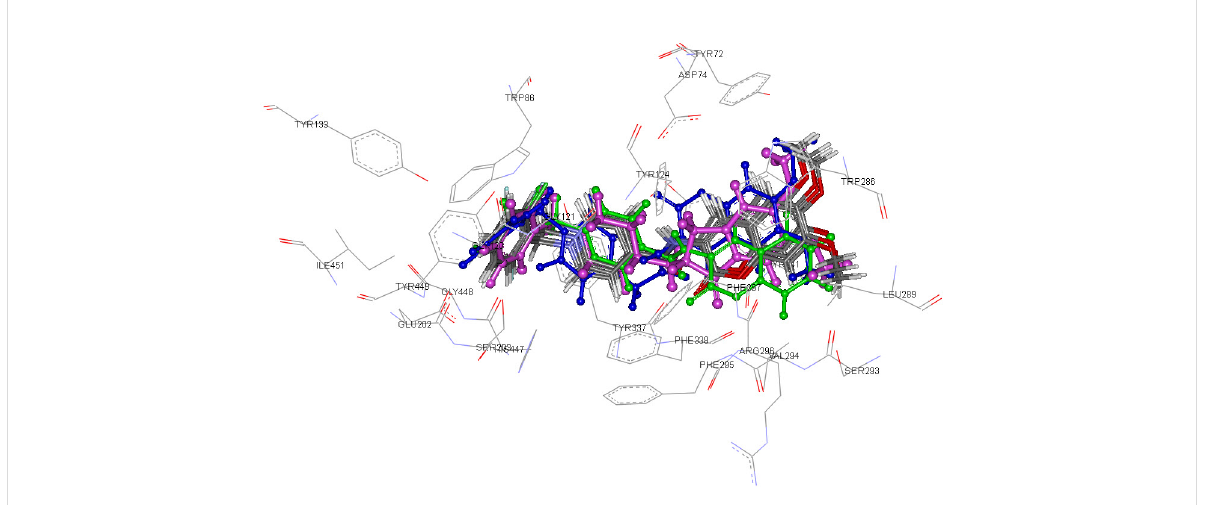
Figure 2: Docked conformations of donepezil (ball-and-stick model; pink), compounds 9a , 9b , 9e , 9h , and 9i (stick model; colored atom-type), com- pound 4a (ball-and-stick model; green), and compound 10a (ball-and-stick model; blue).